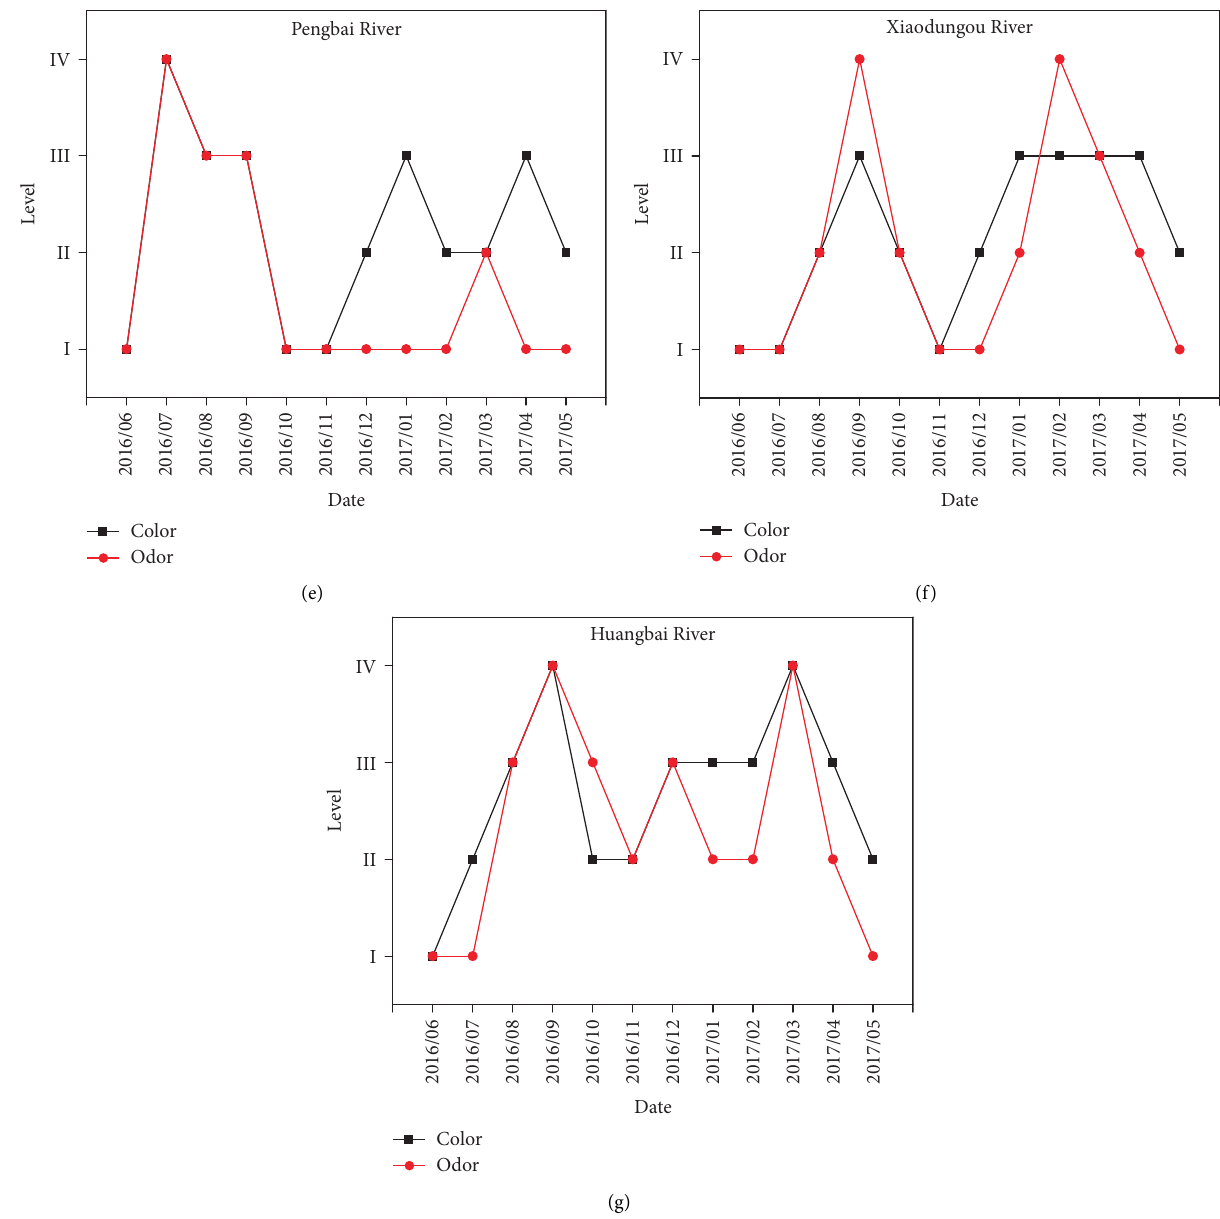
Figure 5: Line chart of water color and odor in each